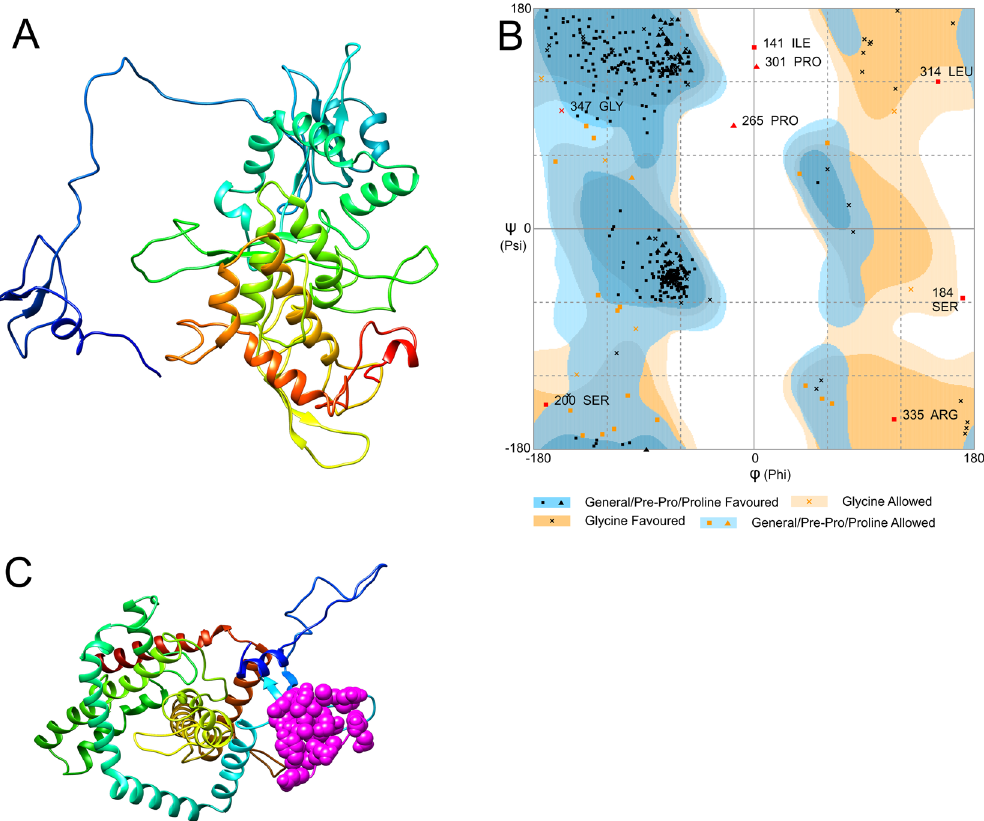
Figure 4. Multi-epitope vaccine modeling and validation ( A ) Represents tertiary structure of multi-epitope vaccine after modeling and refinement. ( B ) Shows validation of multi-epitope vaccine tertiary structure by ramachandran plot where 93% residues were found in favored region, 5.3% residues were found in allowed region and 1.8% residues were lies in outlier region.